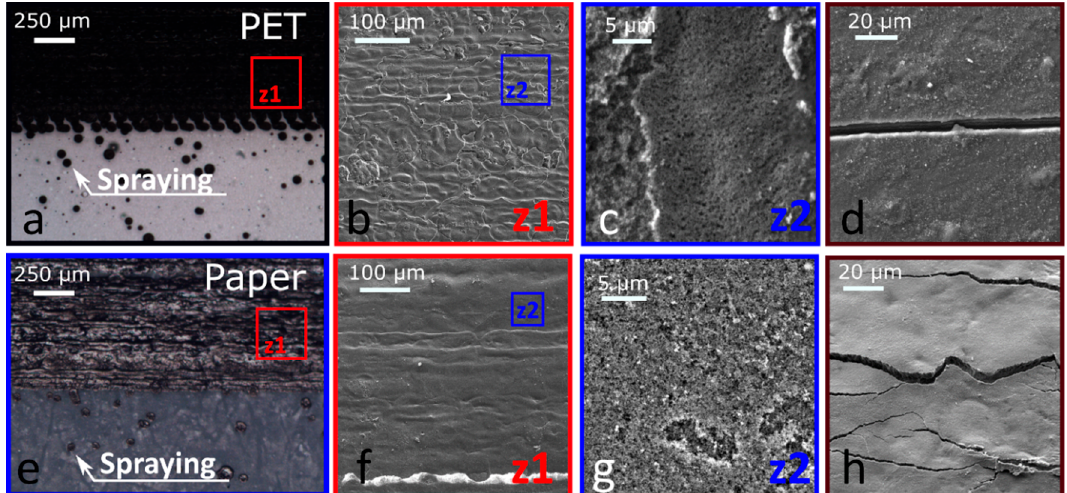
Figure 1. SEM pictures of a 2 mm-wide CB line printed on PET ( a – d ) and paper ( e – h ). ( a ) Imaging of the PET substrate, which highlights the spraying phenomenon inherent to desktop printers. ( b ) Magnification showing that the substrate is fully covered by the ink ( c , d ) some cracks appear but do not prevent conduction. ( e ) Imaging of the paper substrate. ( f ) Magnification showing that the substrate is fully covered by the ink. The paper is soaked by the ink ( g , h ) appearance of cracks at the surface of the CB ink printed